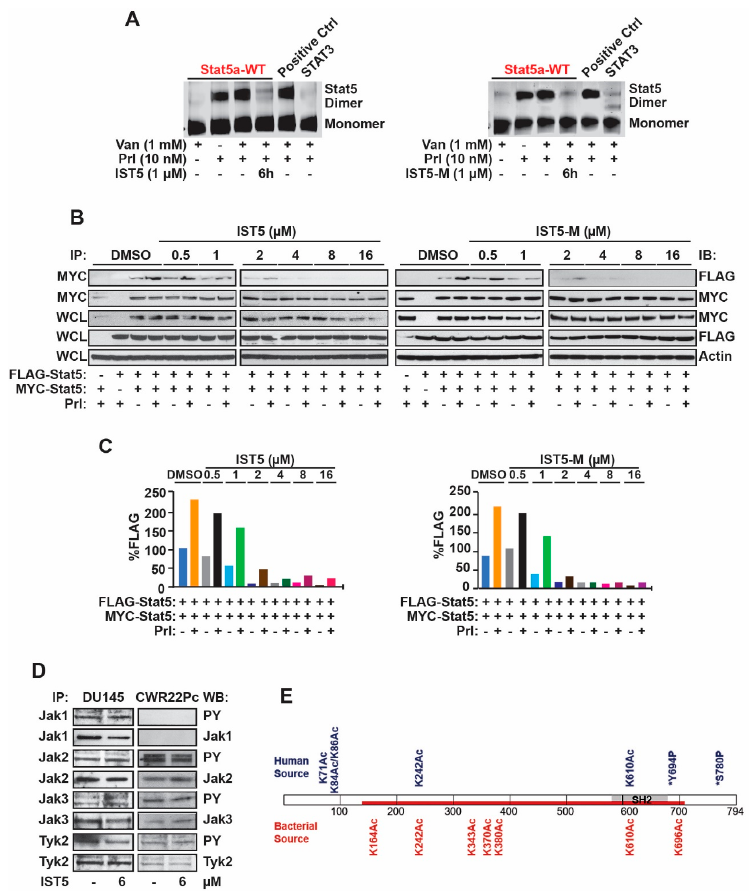
Figure 5. Both IST5 and IST5-M suppress dimerization of Stat5 with similar efficacies in prostate cancer cells. ( A ), IST5 and IST5-M inhibit equally potently dimerization of Stat5 in native-gel-based Stat5 dimerization assay. CWR22Rv1 cells were transfected with STAT5A-eYFP (Stat5 wild type), STAT5A-N642H-eYFP (constitutive activated Stat5 by N642H mutation, as a positive control) or STAT3-eYFP (Stat3 wild type, as a negative control) constructs for 3 days. CWR22Rv1 cells were serum-starved for 16 h, pretreated with vanadate (1 mM) for 2 h, followed by treatment with vehicle, IST5 and IST5-M (1 µM) for 6 h and stimulation with Prl (10 nM) for 1 h. Dimerization of Stat5 was